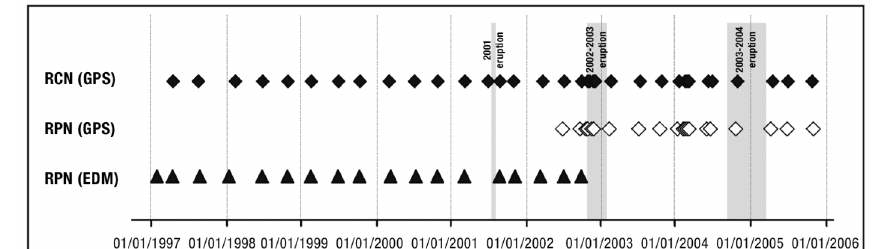
Fig. 3. Chronogram of the surveys carried on the three geodetic networks.